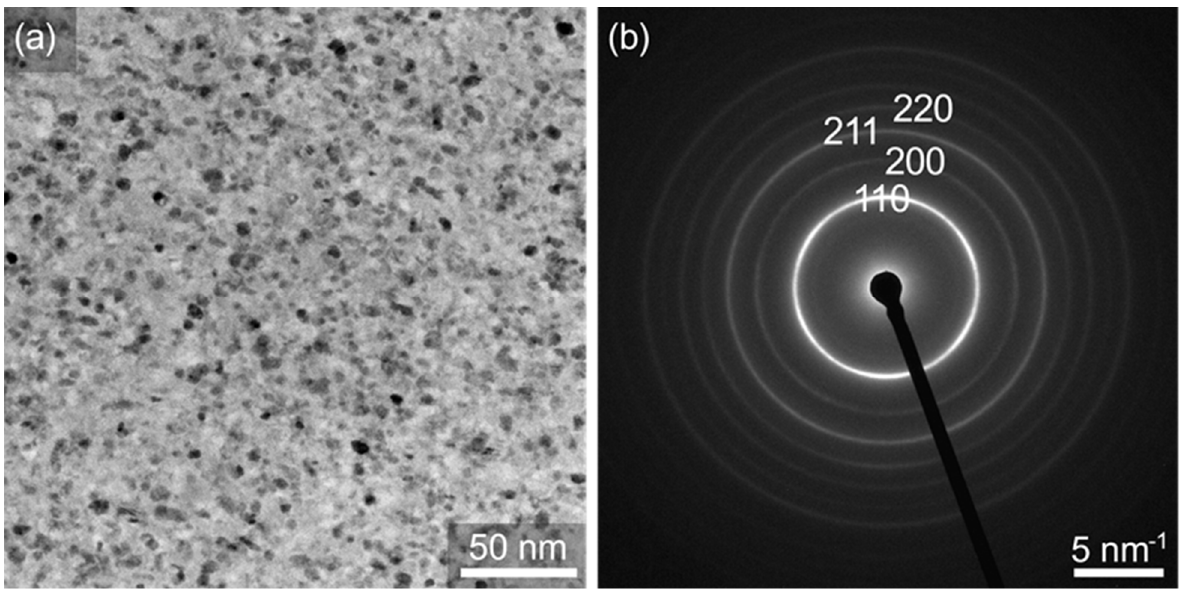
Figure 11. Bright-field STEM micrograph ( a ) and selected-area diffraction pattern ( b ) of alloy B (Fe 81.2 Co 4 Si 0.5 B 9.5 P 4 Cu 0.8 ) after deformation at room temperature, at a pressure of 3 GPa, for 10 turns at a rotation speed of 0.1 turns/min.